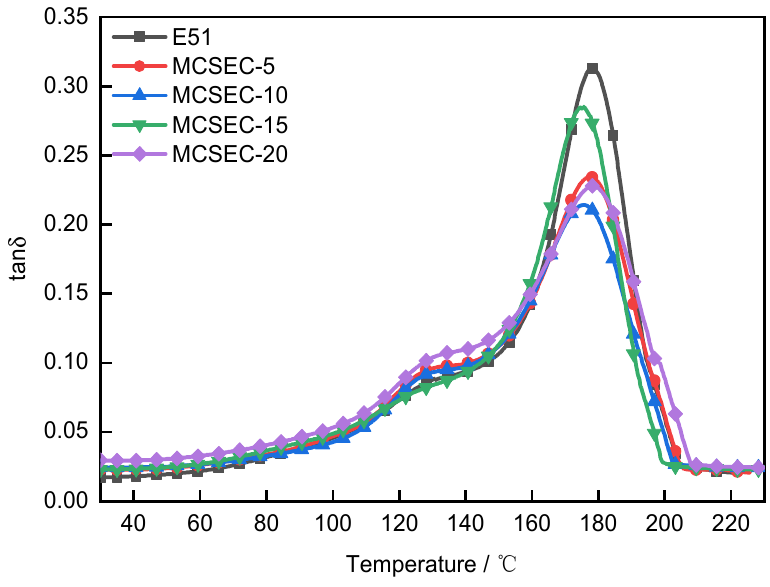
Figure 5. Tan δ of MCSECs with different contents.